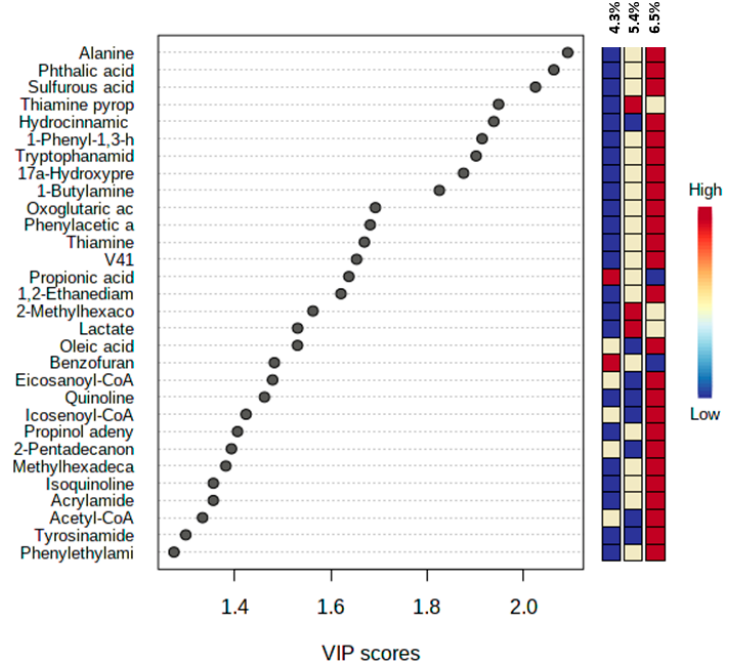
Figure 5. Top 30 Significant compounds. Metabolites accountable for class discrimination with variable importance projection (VIP) > 1 among acid detergent fiber treatments.